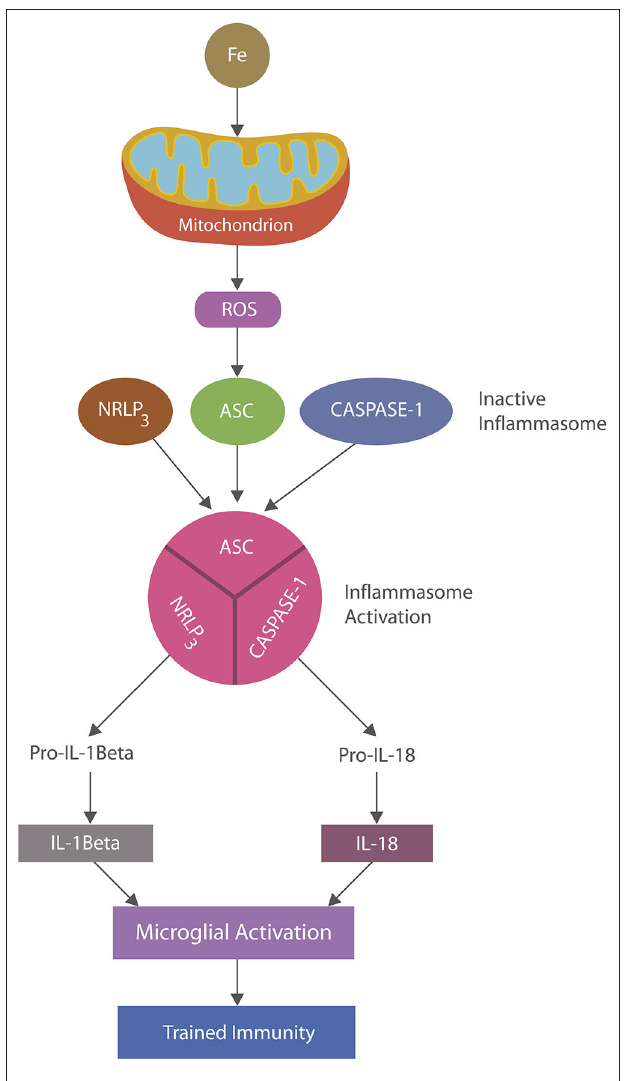
FIGURE 2 | NLRP3 inflammasomes activation: iron-damaged mitochondria, acting as a DAMP, directly or via ROS triggers inflammation by activating NLRP3 inflammasomes. Inflammasomes are comprised of a sensor, the nucleotide-binding oligomerization domain (NOD), in this case the (NOD)-like receptor protein 3 (NLRP3), apoptosis-associated speck-like protein containing a caspase recruitment domain (ASC) and caspase-1 which, upon stimulation, assemble and cleave premature IL-1 beta and IL-18 into their biologically active forms, activating microglia (trained